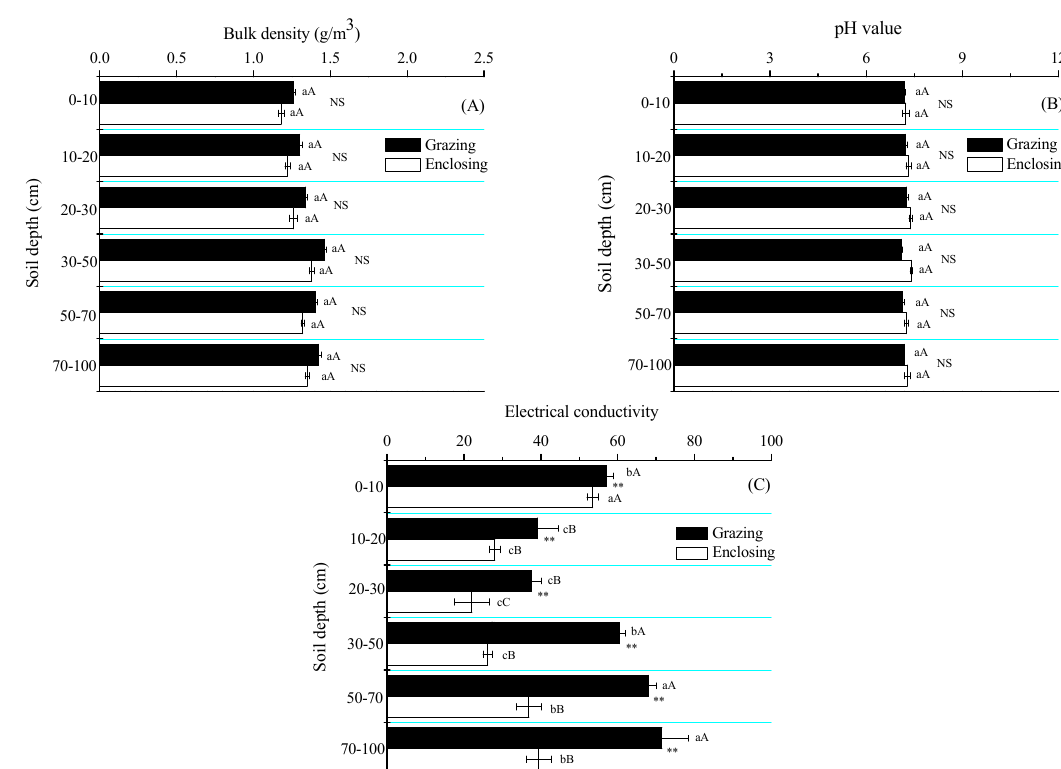
Figure 4. The soil bulk density ( A ), pH value ( B ), and electrical conductivity ( C ) of treatments. Note: ** show significant differences at p < 0.01 of bulk density, pH value, and electrical conductivity in each soil layer between two treatments, and NS shows no difference ( t -test). Lowercase and capital letters show significant differences in bulk density, pH value, and electrical conductivity at p < 0.05 and p < 0.01 among different soil layers in each treatment by ANOVA. Error bars are one standard deviation.